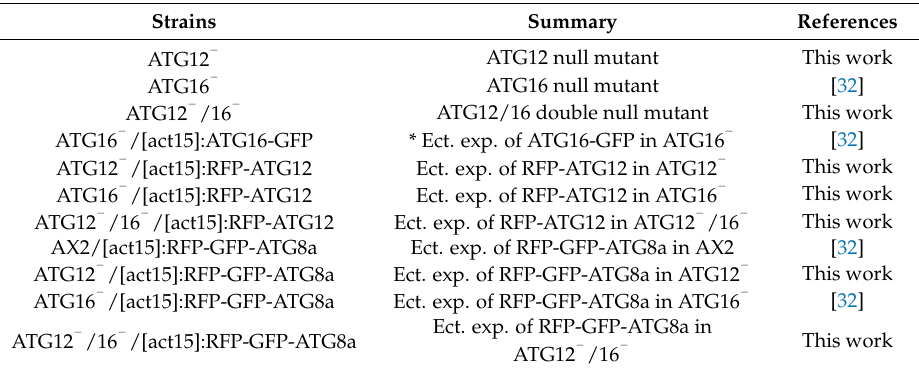
Table 1. D. discoideum strains used in this